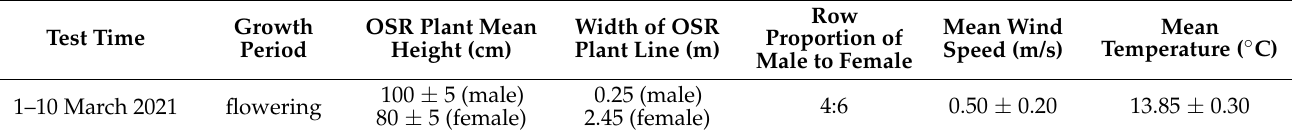
Table 1. The OSR characteristics and weather conditions.